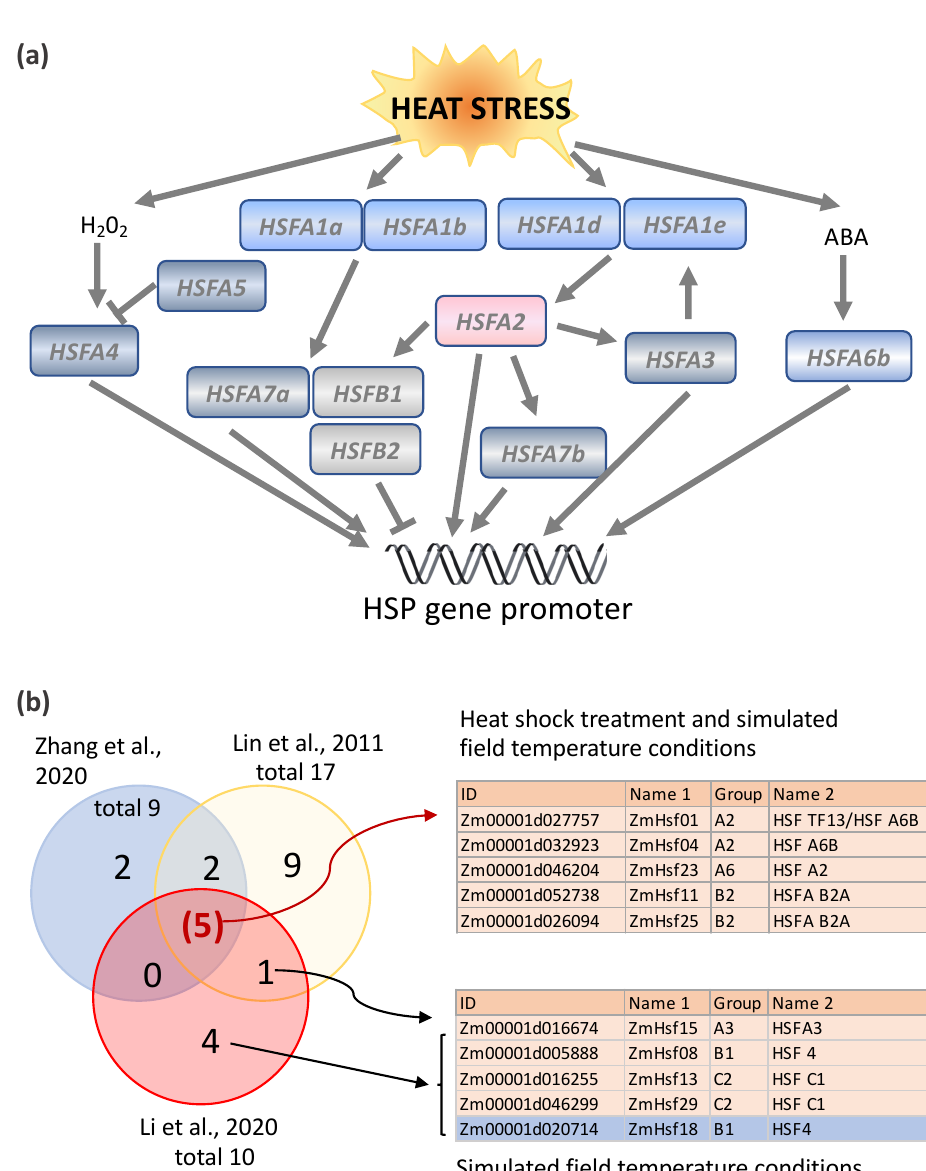
Figure 3. Heat stress induction of the HSF genes in Arabidopsis and maize. ( a ) Heat stress induction of a transcriptional cascade involving HSFA genes in Arabidopsis. Modified from Nishizawa-Yokoi et al., 2011 [34] and Huang et al., 2016 [40]. ( b ) Comparison of HSF induction in response to step heat shock treatment (Lin et al., 2011 [29] and Zhang et al., 2020 [30]) vs. ramped heat stress conditions (simulated field conditions in which temperatures are slowly ramped up to maximum daily temperature), Li et al., 2020 [14]). Five of the 31 maize HSFs (light orange color indicated) were identified as induced under both the step heat shock treatment and ramped heat stress conditions in maize, including two A2 subgroup HSFs, two B2 HSFs, and one A6 subgroup HSF. One B1 subgroup HSF and two C1 subgroup HSFs (light orange) were specifically upregulated in response to ramped heat stress conditions, while one B1 HSF (blue) was downregulated under the same conditions. HSFA, class A heat shock transcription factor; HSFB, class B heat shock transcription factor; ABA, abscisic acid; HSP, heat shock protein; and HSF TF, heat shock transcription